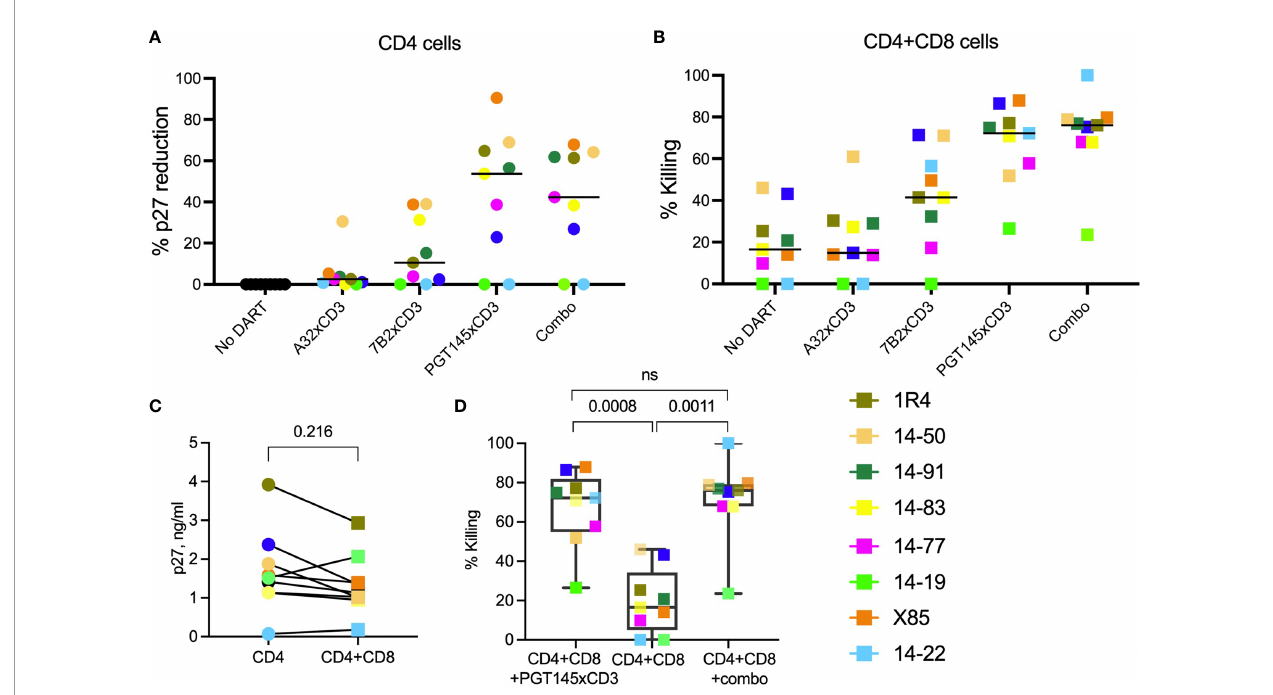
FIGURE 4 | HIVxCD3 DART molecule-mediated killing of SHIV-infected RM CD4+ T cells. In vitro activated primary CD4+ T cells from SHIV.CH505.375H-infected RMs were cultured without or with DART molecules in the absence (A) or presence (B) of autologous CD8+ effector cells at an E:T ratio of 0.03:1. The A32, 7B2 and PGT145 DART molecules at 1 µg/mL were added individually or as a triple combination (Combo) at 1 µg/mL each. The reduction in p27 levels (A) and DART- mediated killing (B) was analyzed by p27 ELISA in culture supernatants 48 hours post treatment. The circles represent cultures with CD4 cells, squares represent cultures with CD4 and CD8 cells. Each colored symbol represents an individual animal. The horizontal black bars represent median values. Statistical analysis of p27 levels (C) or % killing (D) between indicated groups was performed using Wilcoxon Test at the signi fi cance level of 0.05. NS, not signi fi